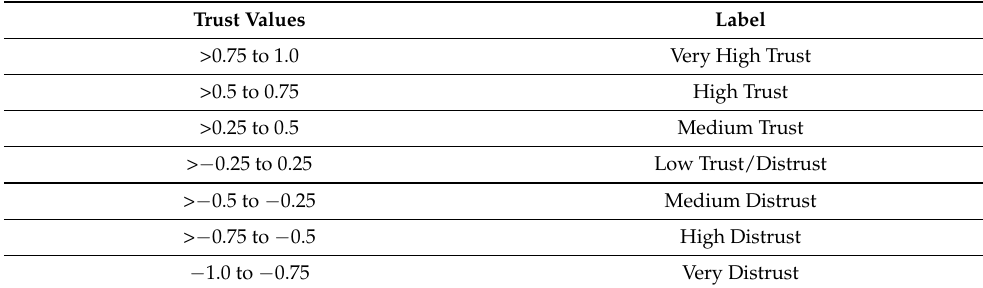
Table 10. Possible Trust Values for